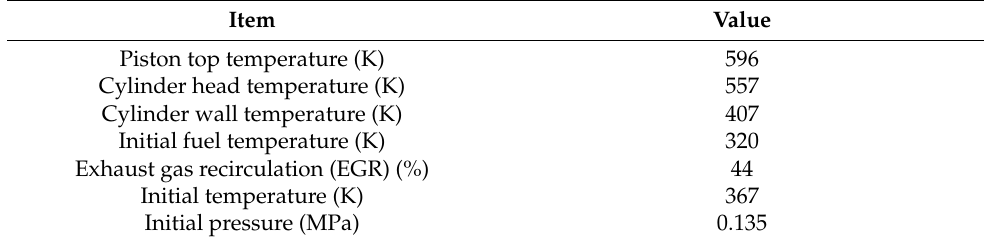
Figure 3. Simulation model: ( a ) piston bowl profile; ( b ) bottom dead center (BDC); ( c ) calculation grids. The initial calculation conditions and boundary parameters are shown in Table 4, among which the simulated initial temperature, initial pressure, initial fuel temperature, and EGR were obtained based on experiments. The opposite cut surface of the sector was used as the cycle boundary. The cylinder wall, cylinder head, and the top of the combustion chamber were used as fixed wall surfaces. The initial temperatures around chambers were endowed with experienced data. Table 4. The boundary conditions of calculation.